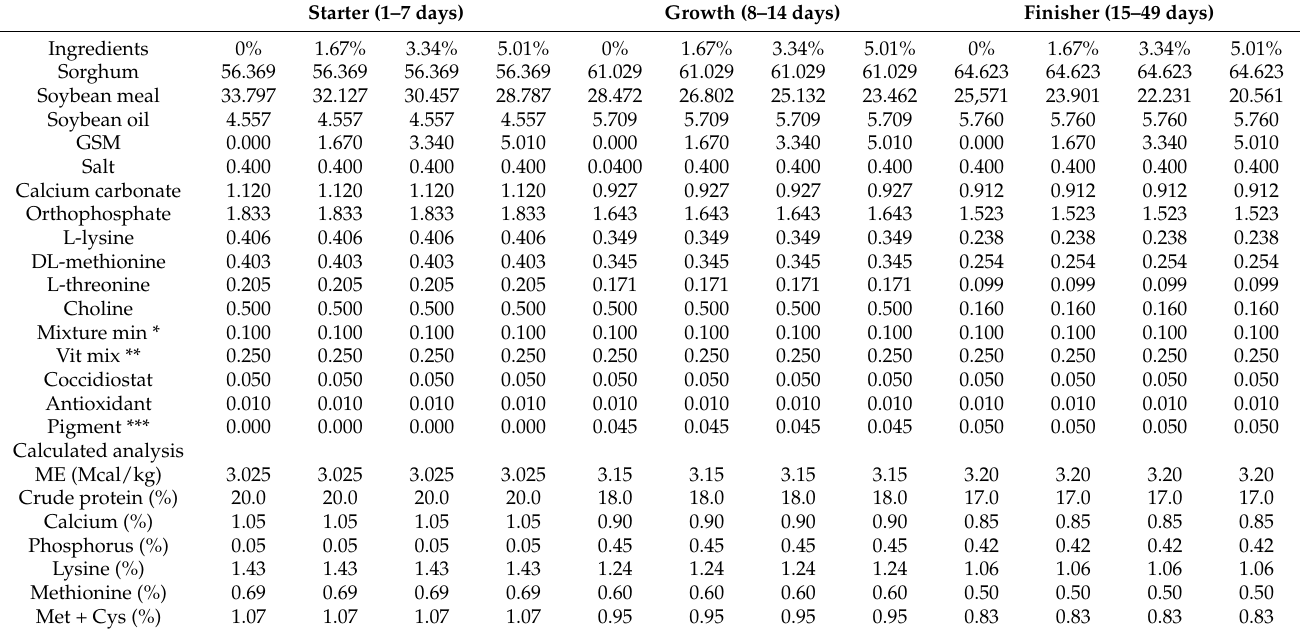
Table 1. Composition of the ingredients and nutrients in the experimental